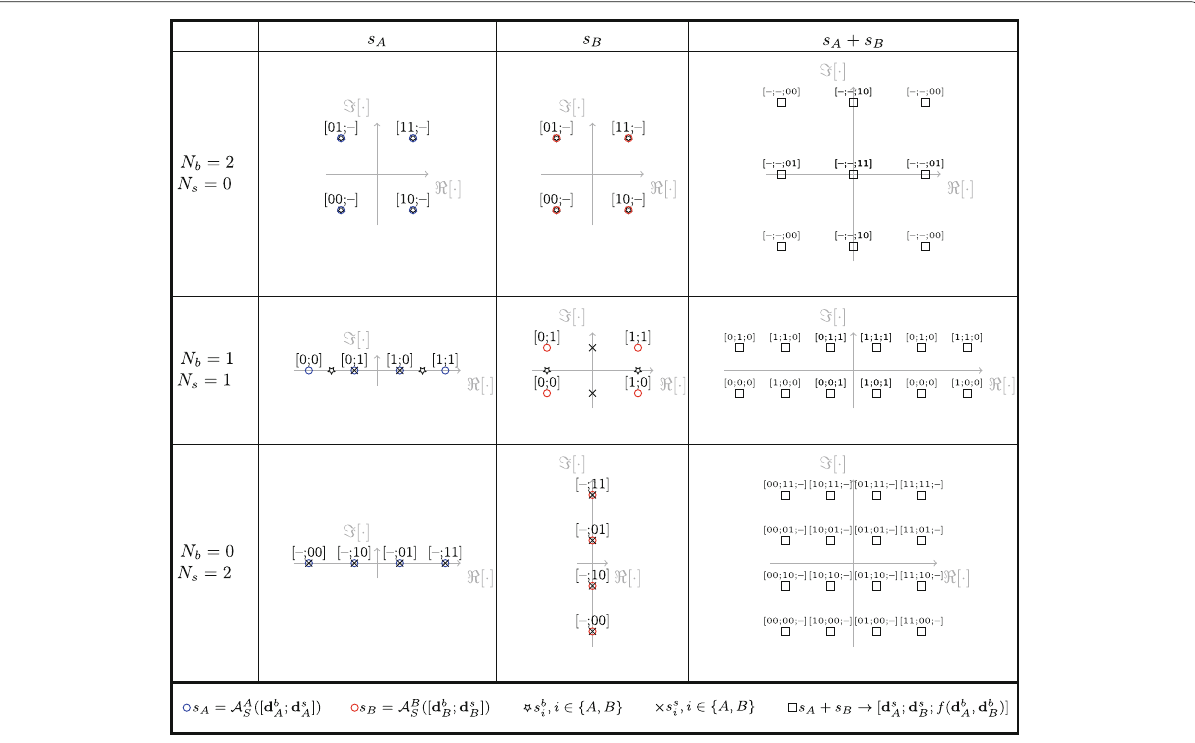
(cid:7) (cid:8) ⊕ d b = d b d b , d b A B A B